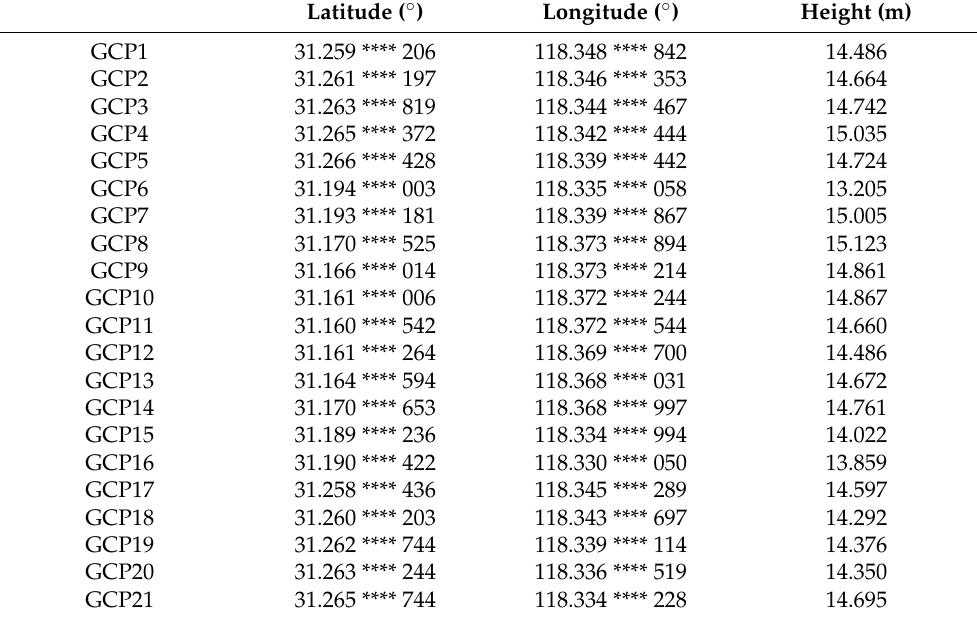
Table 2. Coordinates of the ground control points (GCPs) measured using the RTK S86T system. Latitude ( ◦